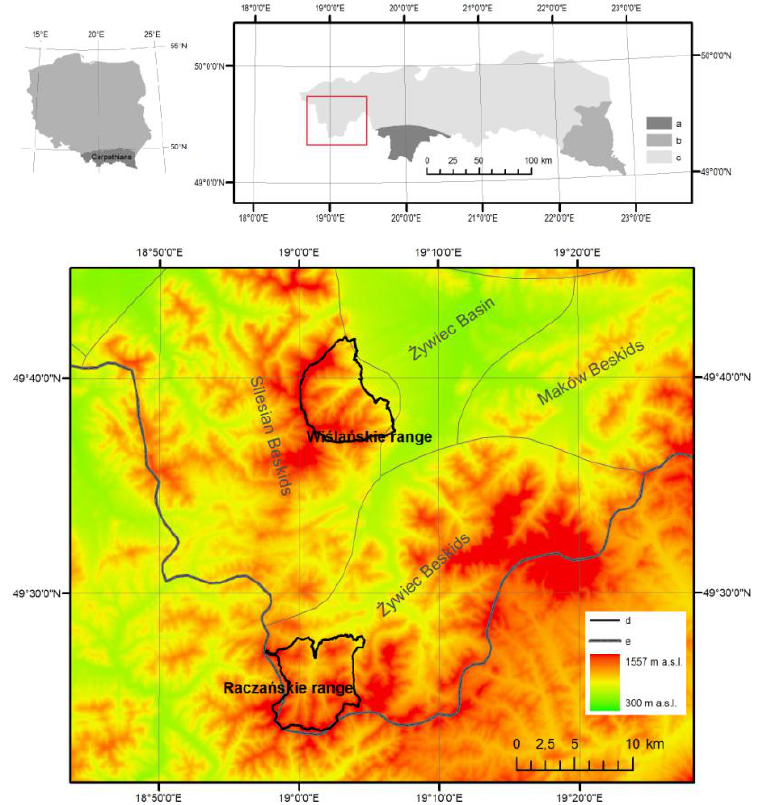
Fig. 1. Location of the study area (source: author’s own elaboration) a – The Central Western Carpathians, b – The Outer Eastern Carpathians, c – The Outer Western Carpathians, d – the study area boundary, e – state